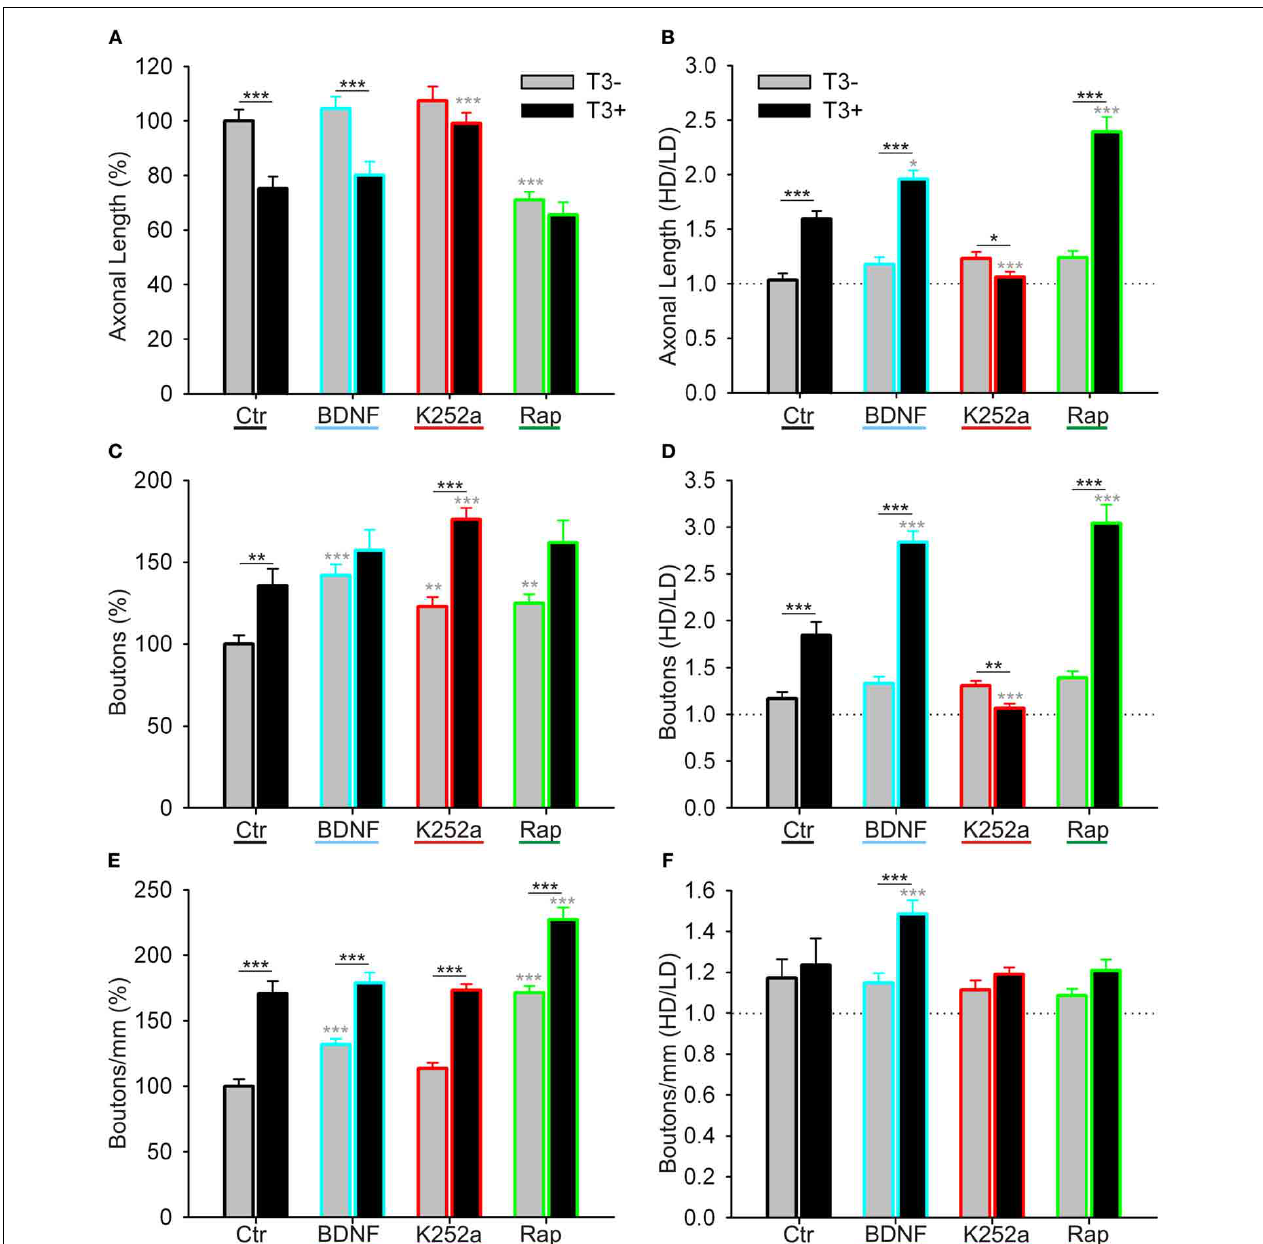
FIGURE 12 | Quantitative measurements of L-GABAergic axons and boutons. Graphs illustrate the effect of T3 (gray bars: T3 − ; black bars: T3 + ), of BDNF (blue contours), trkB blockade (red contours), and mTOR blockade (green contours) on GABAergic axonal length/field (A,B) , bouton density/field (C,D) , and bouton density/mm axon (E,F) . (A,C,E) show